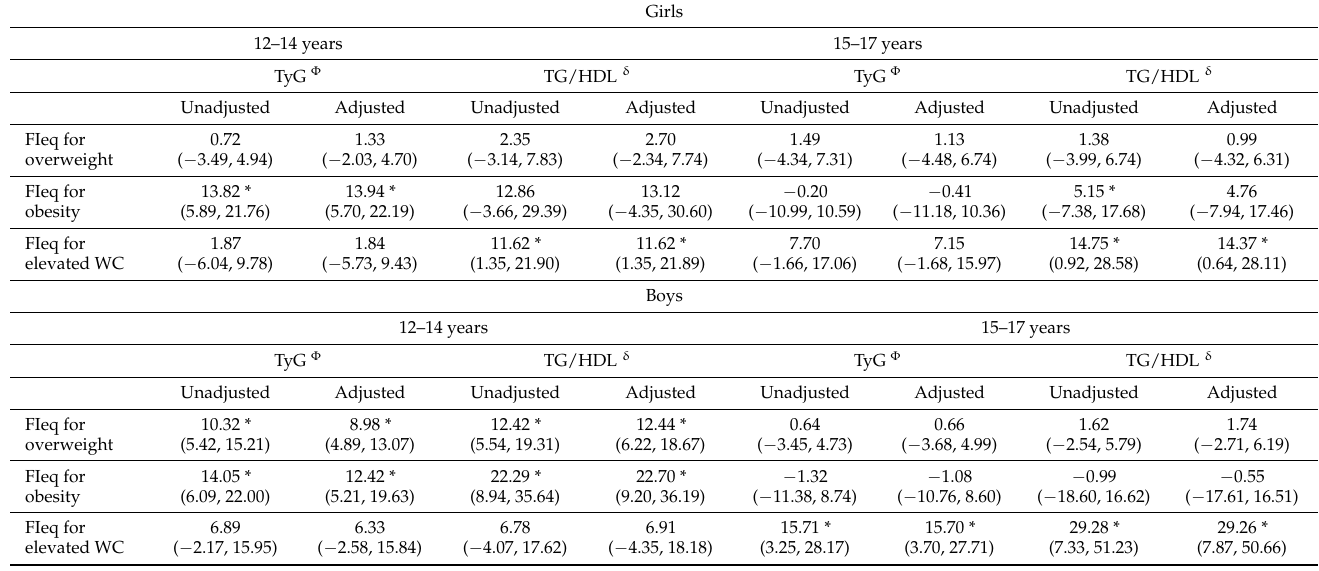
Table 3. Unadjusted and adjusted ‡ fasting insulin equivalent (FIeq) for overweight, obesity, and elevated WC with insulin resistance markers and 95% confidence intervals stratified by sex and age in 37,815 adolescents included in the Study of Cardiovascular Risk Factors (ERICA, 2013–2014).